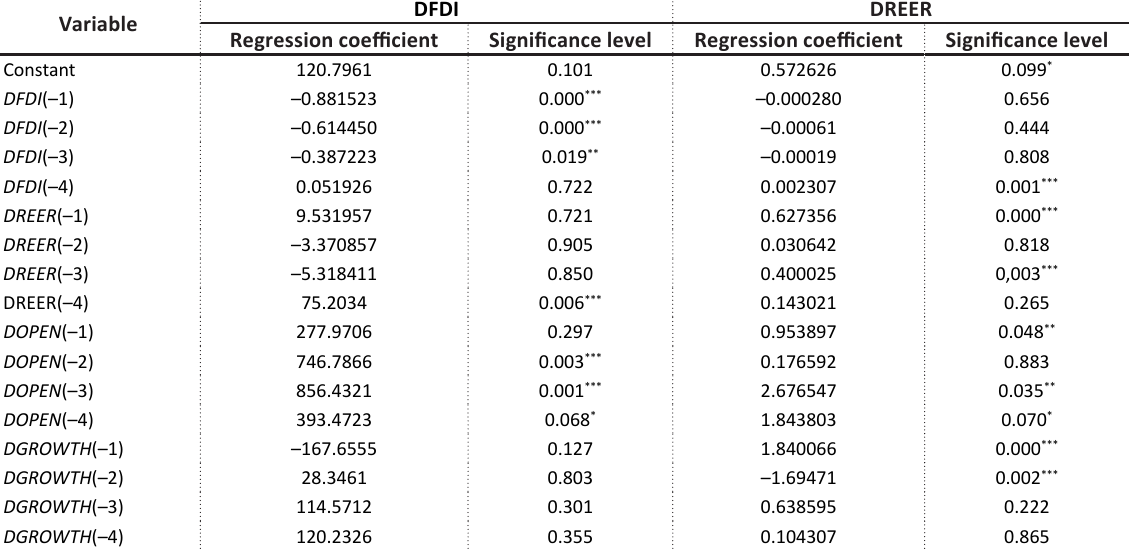
Source: Authors’ analysis